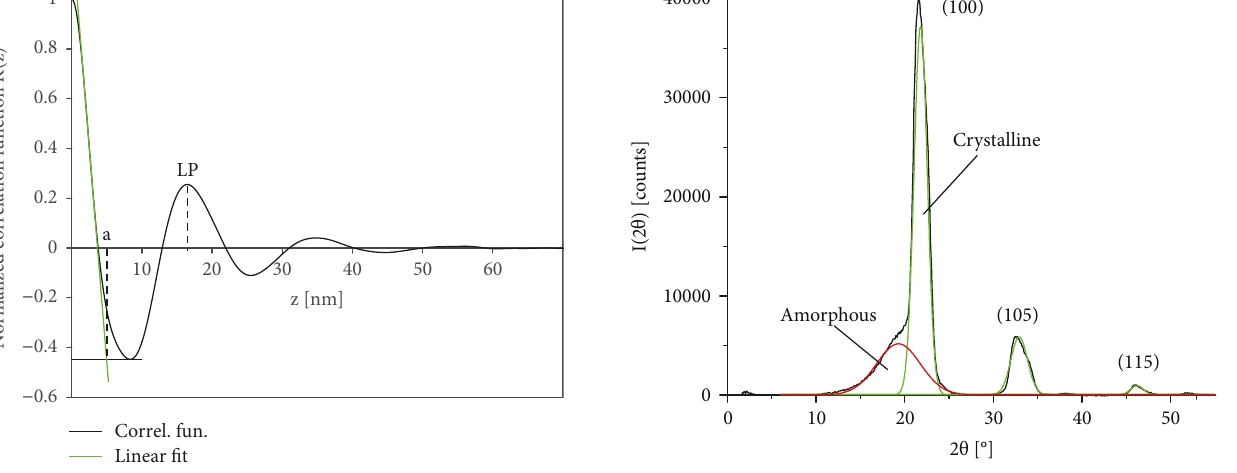
Figure 2: Example for the correlation functions obtained (Delrin, injection molded, 110 ° C mold temperature, CT specimen, “ Delrin_IM_110 ° C-MT ” ) and scheme of the analysis used.